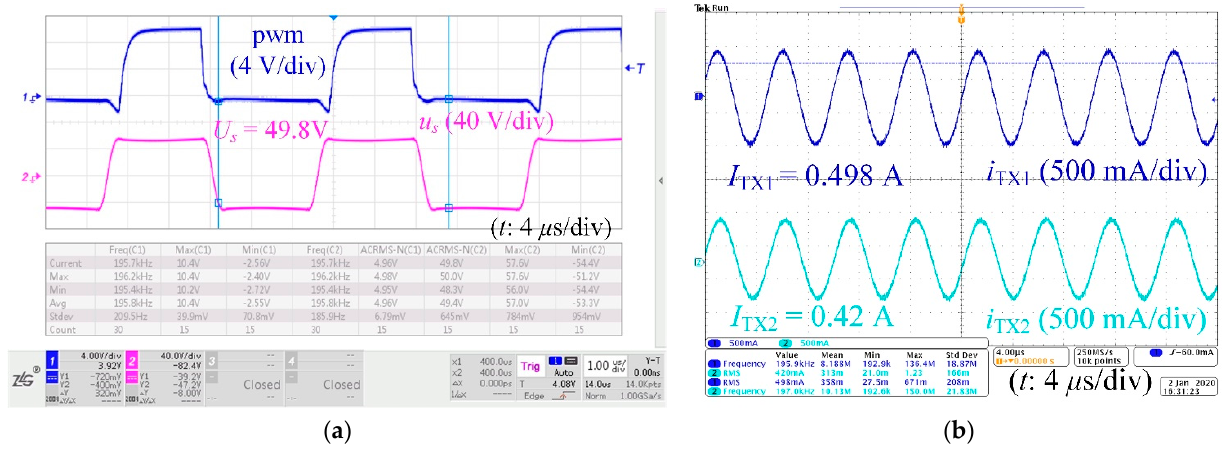
Figure 15. As h = 32.2 cm, m = n = 4, ( a ) the input voltage Us ; ( b ) the currents in the TX1 and TX2.